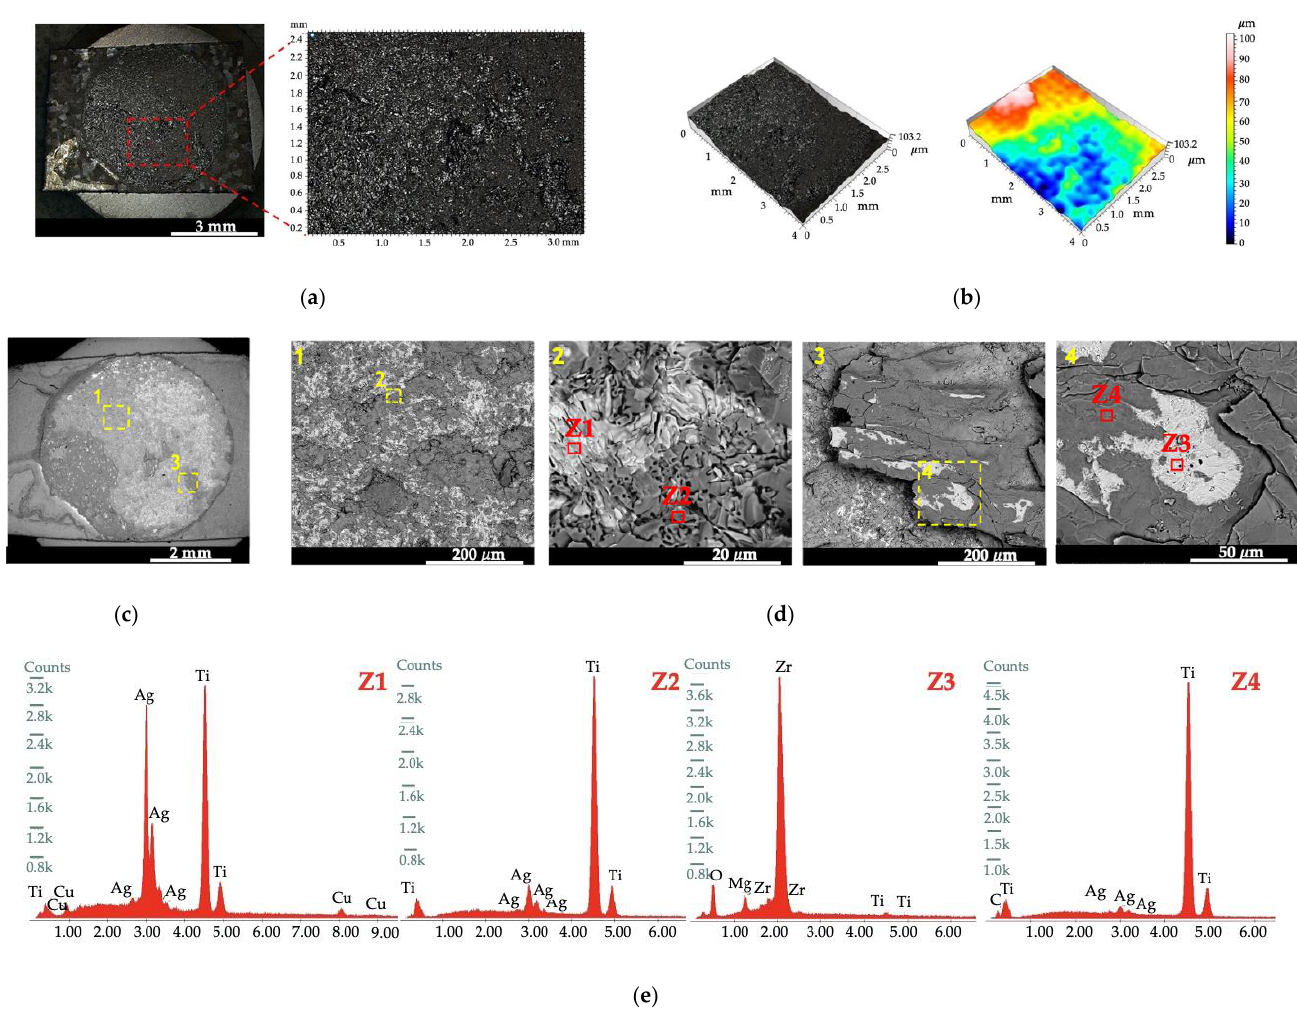
Figure 8. ( a ) Digital microscopy image of the fracture surface on the Ti6Al4V side of joints, ( b ) 3D representation the region marked in ( a ); ( c ) SEM image of the fracture surface and ( d ) magnifications of zones marked in ( c , e ) EDS spectra corresponding to the zones marked in ( d